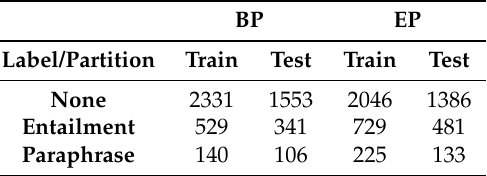
Table 2. Distribution of labels in ASSIN